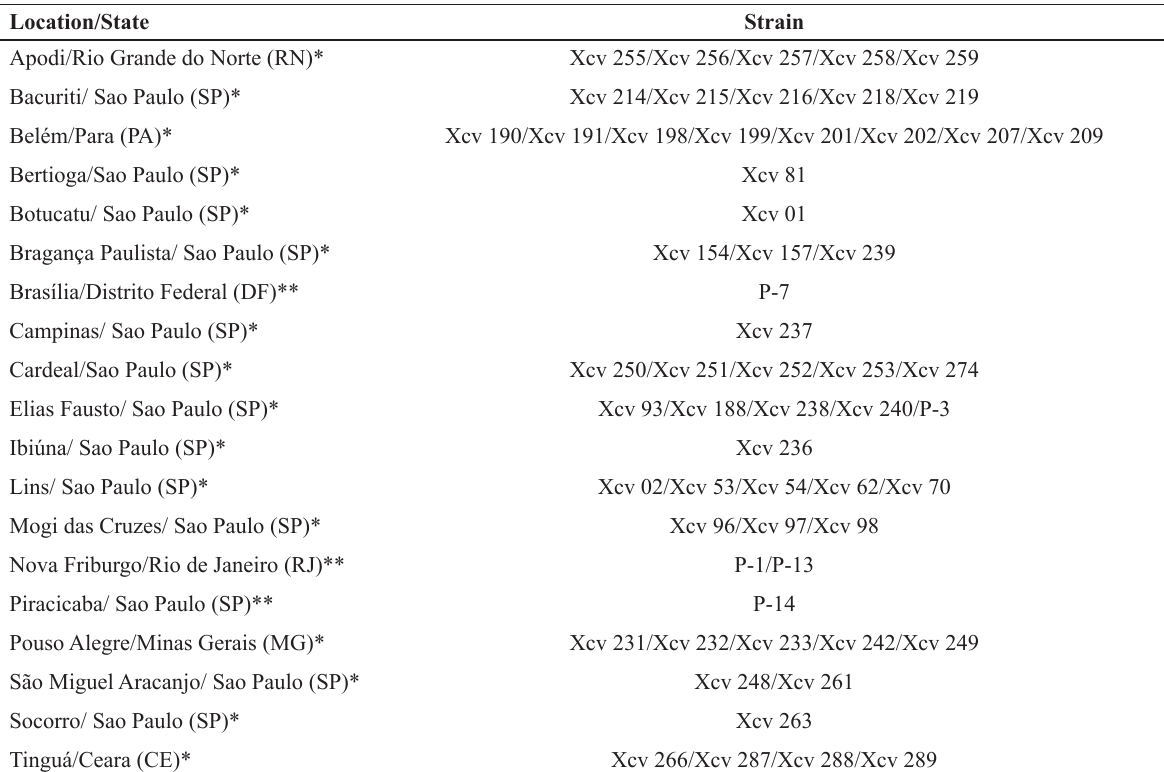
Xanthomonas euvesicatoria strains from pepper evaluated in this study. Location/State